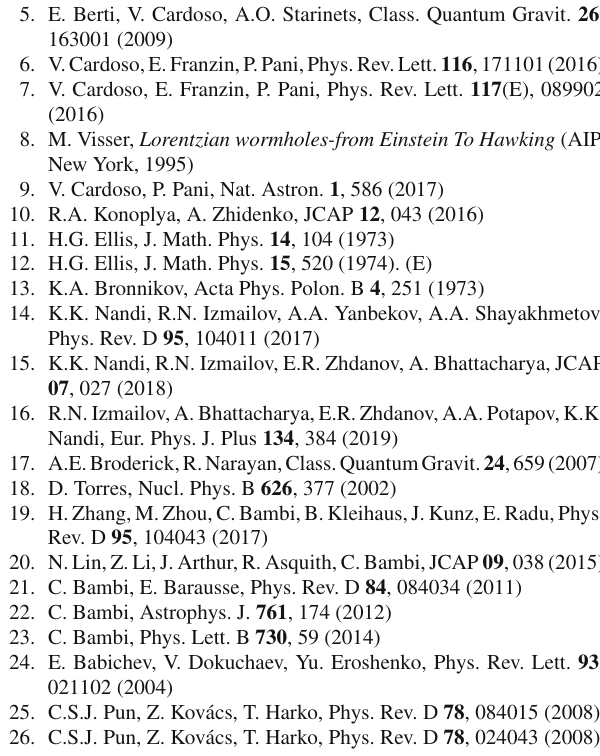
strain the temperature profiles of their accretion disks